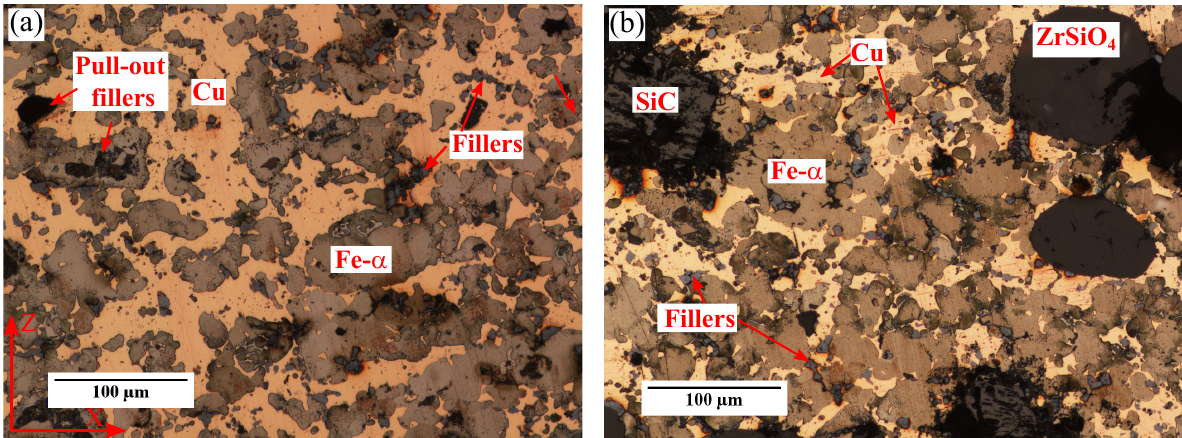
Figure 2. ( a ) Optical microscopy micrograph at × 20 of the MM material after Nital etching. ( b ) Optical microscopy micrograph at × 20 of the MMCs material after Nital etching.